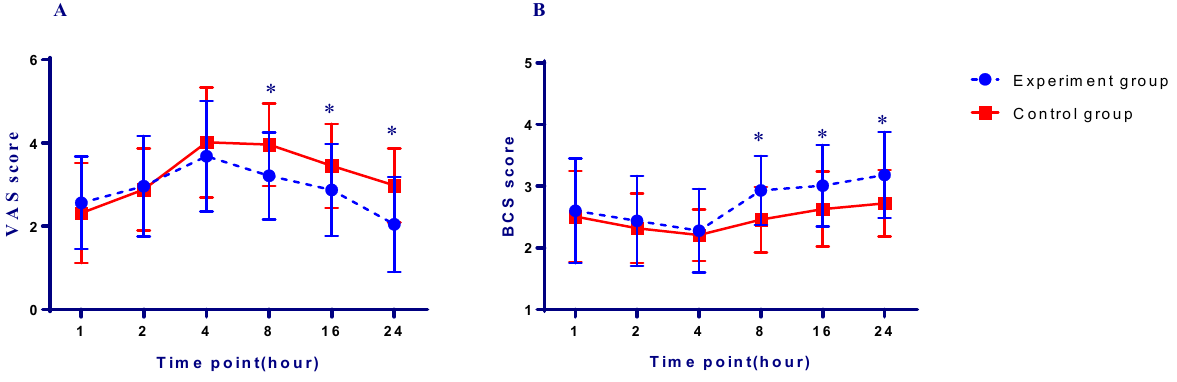
Figure 1: Visual Analogue Scales (VAS) and Bruggrmann Comfort Scale (BCS) score comparison between two groups of different time points (A: VAS score; B: BCS score). *p<0.05.